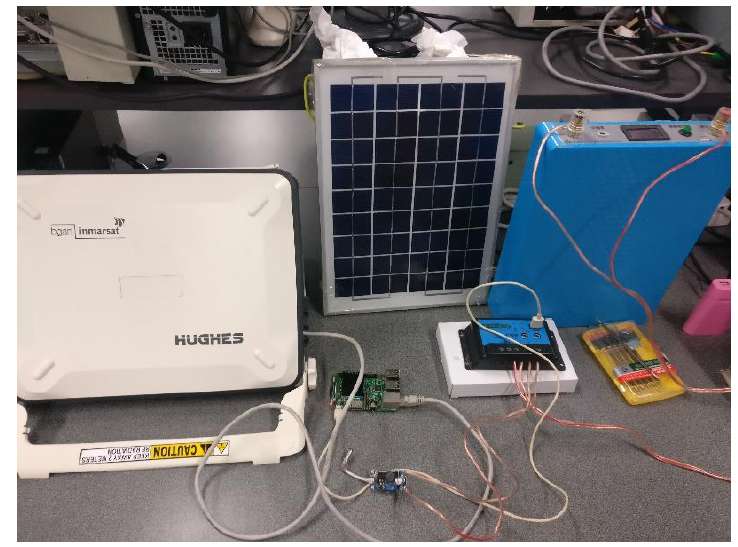
Figure 2. Implementation of the designed solar-powered satellite access point.